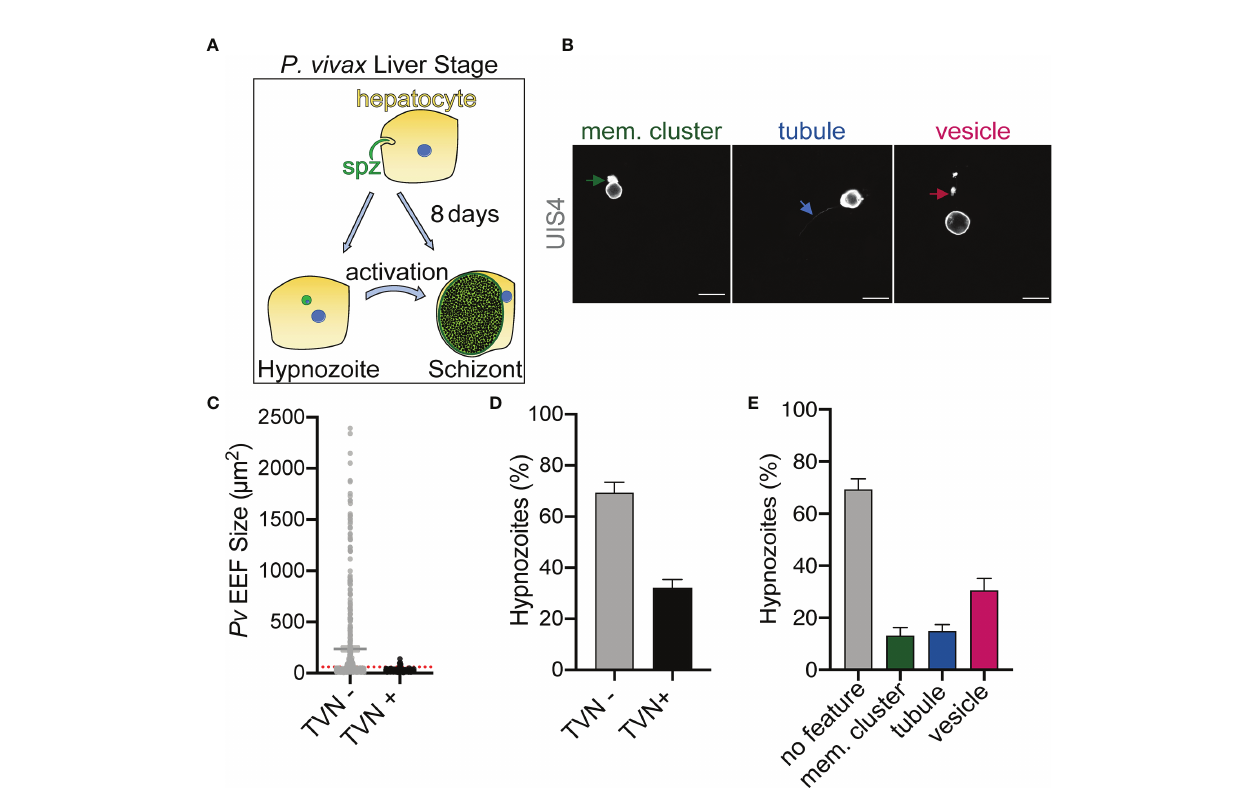
FIGURE 1 | P. vivax -infected PHH contain TVN features. (A) Schematic representing P. vivax liver stage infection. (B) Examples of TVN features including extended membrane cluster (mem. cluster, green arrow), tubule (blue arrow) and vesicles (magenta arrow) in P. vivax -infected PHH. Cells stained with anti- Pv UIS4 (grey). Scale bar is 10 µm. (C) Relative size of P. vivax EEFs that are TVN- (grey) or TVN+ (black). Red dotted line indicates cut off for hypnozoites (60 µm 2 ). (D) Percentage of TVN- (grey bar) or TVN+ (black bar) P. vivax hypnozoites. (E) Characterization of P. vivax hypnozoites containing TVN+ or TVN- EEFs. Percentage of each characteristic including extended membrane cluster (mem. cluster, green bar), tubule (blue bar), and vesicle (magenta bar) is indicated. Grey bar indicates percentage of TVN- hypnozoites. (B – E) Assessed at 8 dpi. Data reported as mean ± SEM (3 independent wells assessed with >200 EEFs, n=2 biological